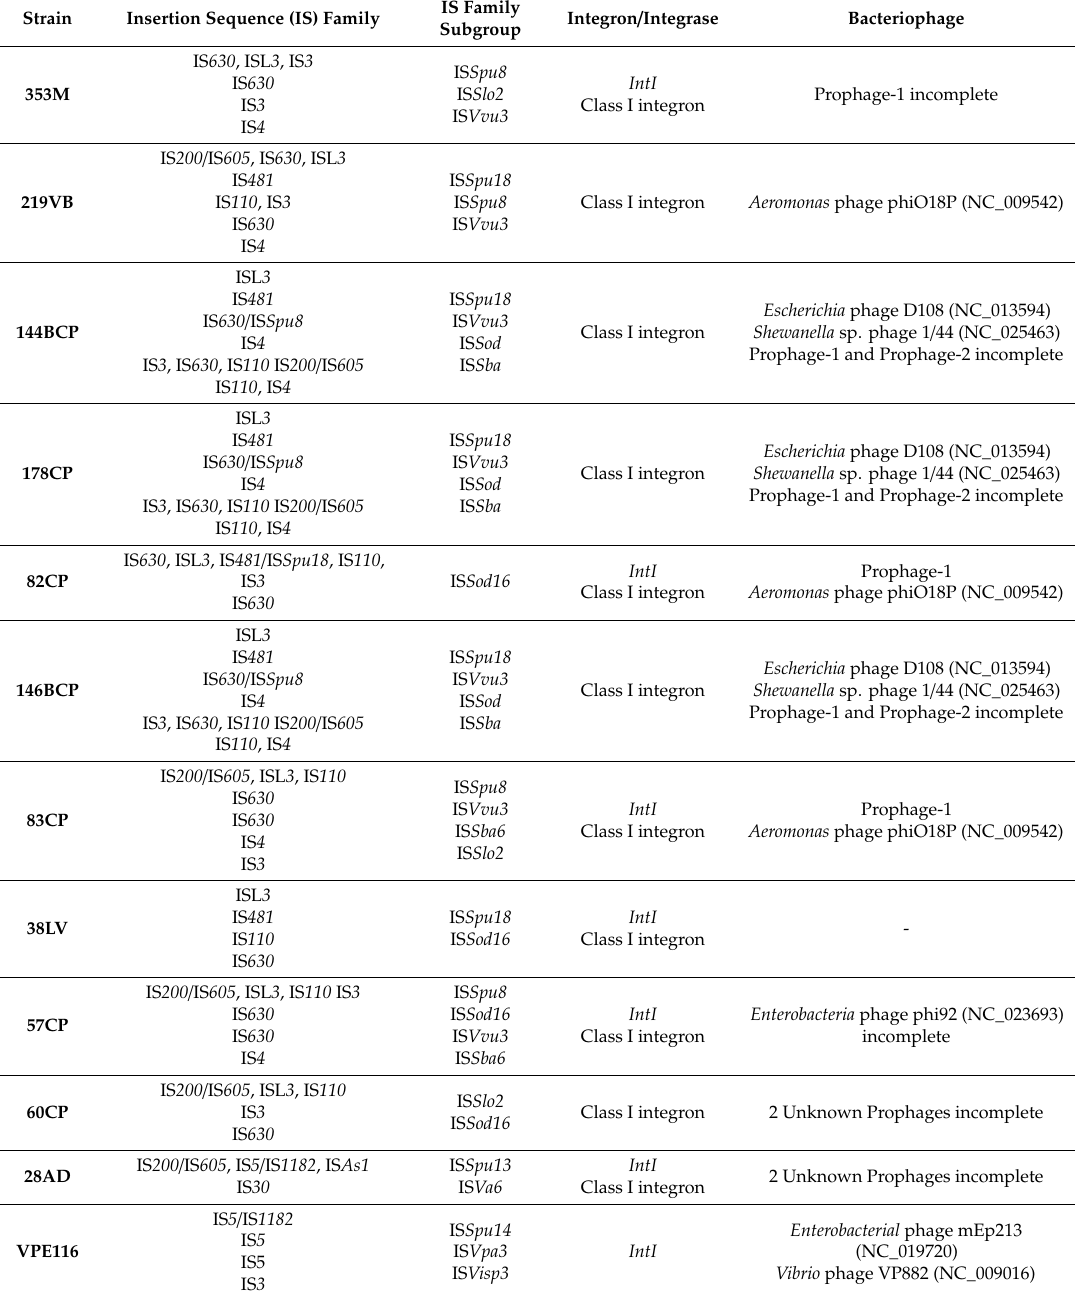
Table 3. Summary of mobile genetic elements found in S. algae and Vibrio spp.